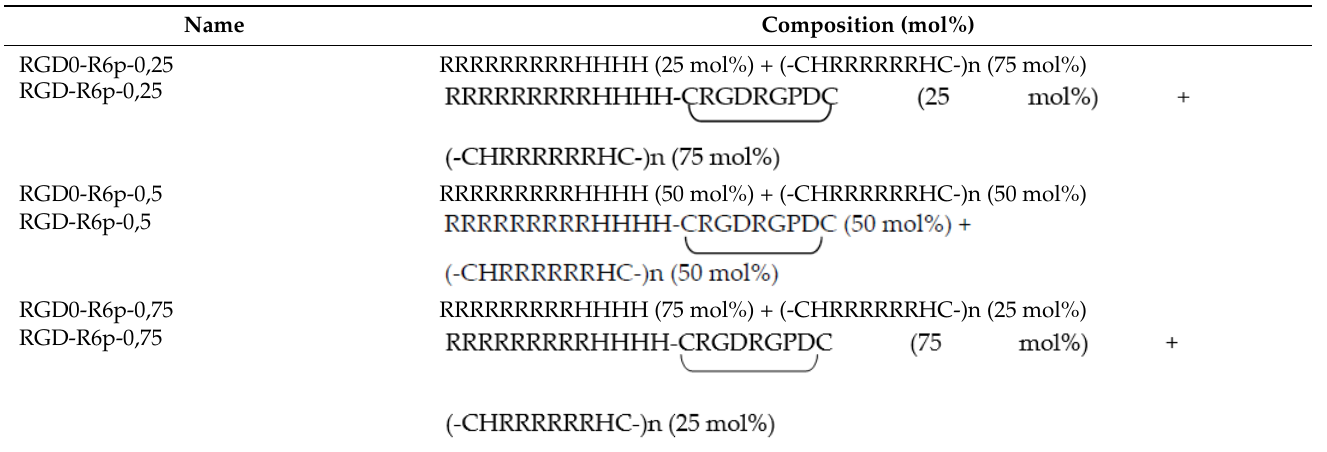
Table 1. Design and composition of the carriers.